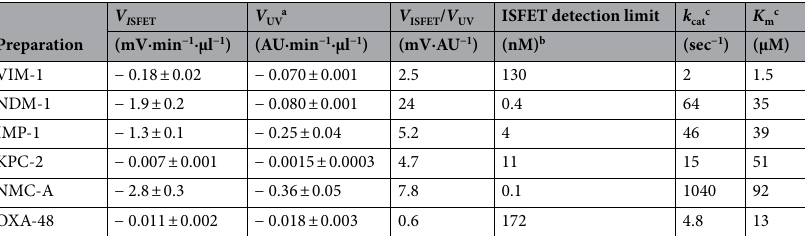
Table 1. Imipenem hydrolysis monitored through the ISFET sensor and UV spectrophotometry using crude enzyme preparations. a Data represent means ± standard deviations of three measurements. b Approximate enzyme concentration in the final measurement solution. c Data published in references 39–44. V ISFET : Voltage fall per minute per μl of enzyme preparation used. UV: absorbance units fall at 300 nm during hydrolysis of 80 μM imipenem in the ZnSO 4 solution per minute per μl of enzyme preparation used.